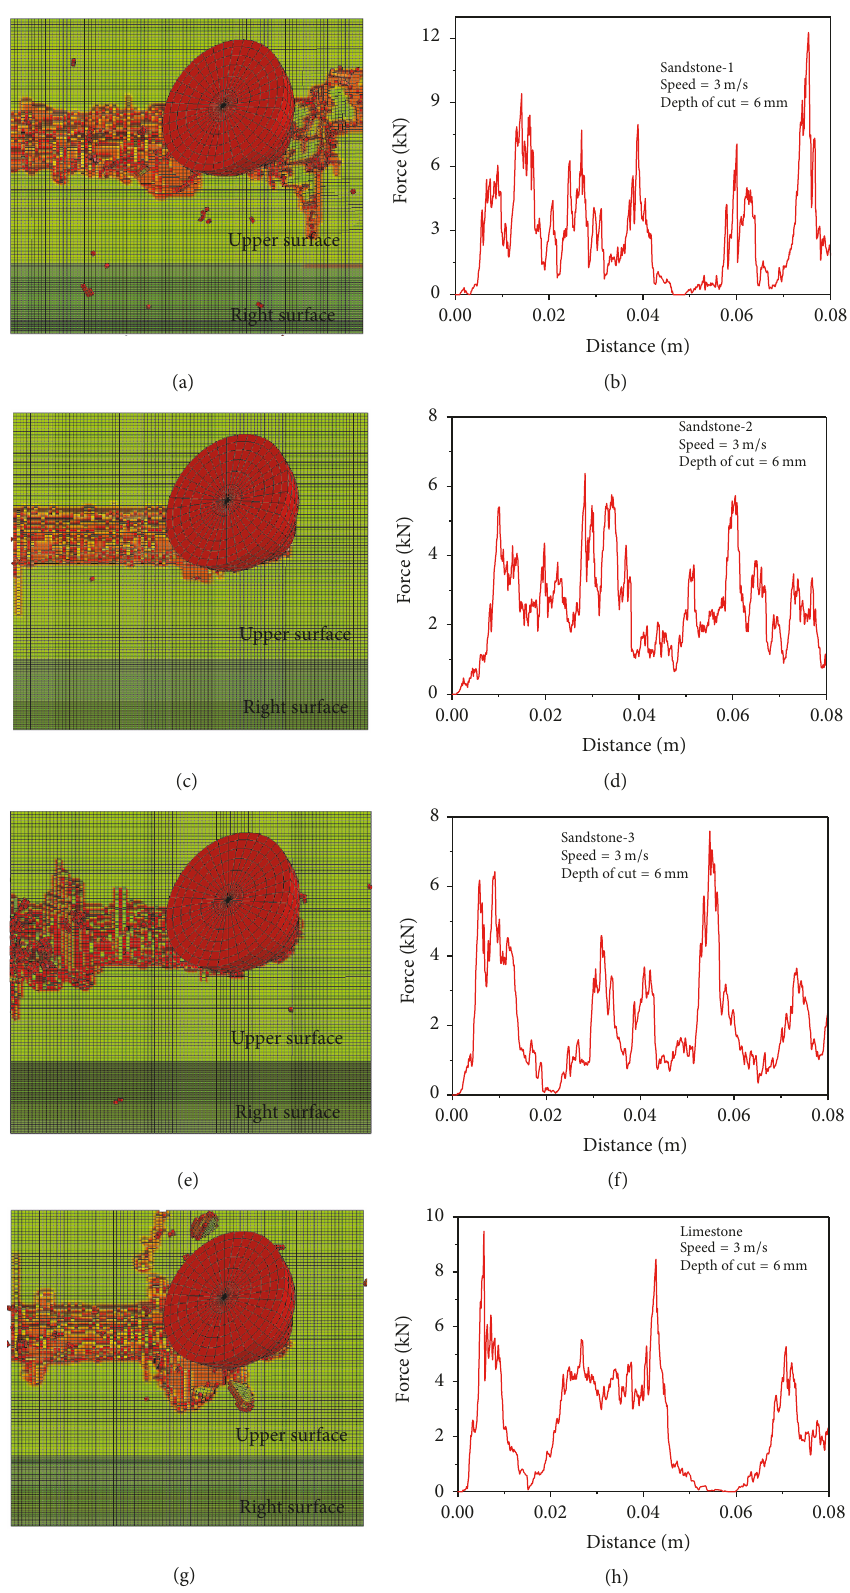
Figure 8: The cutting results for a cutting depth of 6 mm and a cutter speed of 3m/s: (a), (c), (e), and (g) are the cutting results for sandstone- 1, sandstone-2, sandstone-3, and limestone, respectively, and (b), (d), (f), and (h) are the variation in the cutting force with distance for sandstone-1, sandstone-2, sandstone-3, and limestone,